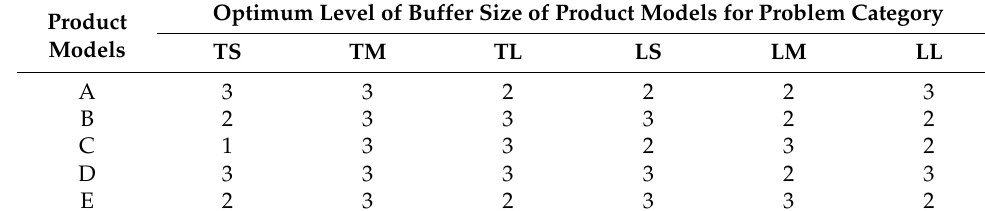
Table 4. Optimum level of buffer size of product models against each category of problem.